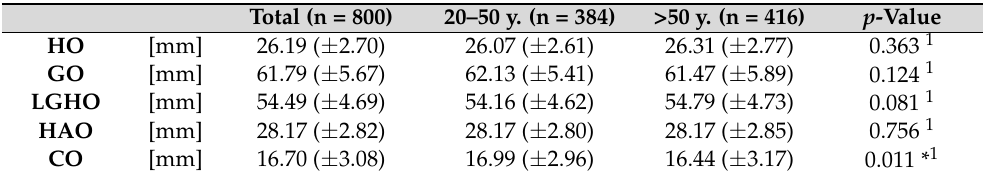
Table 2. Analysis of age-specific (age in years) differences between offset